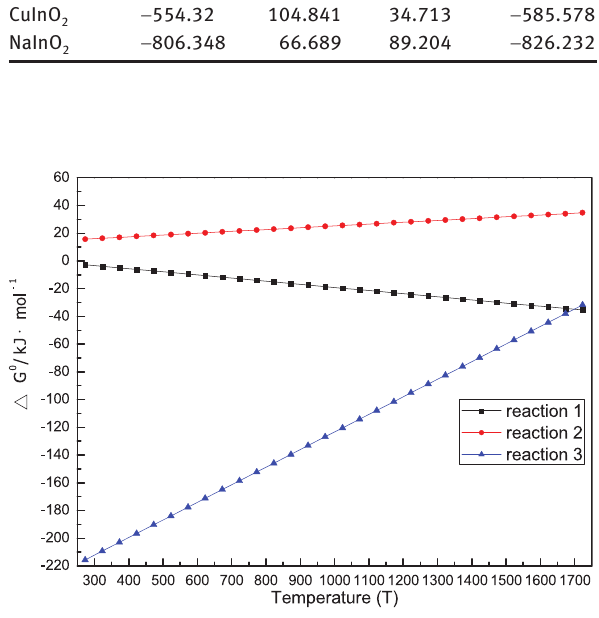
Fig. 1: The curves of